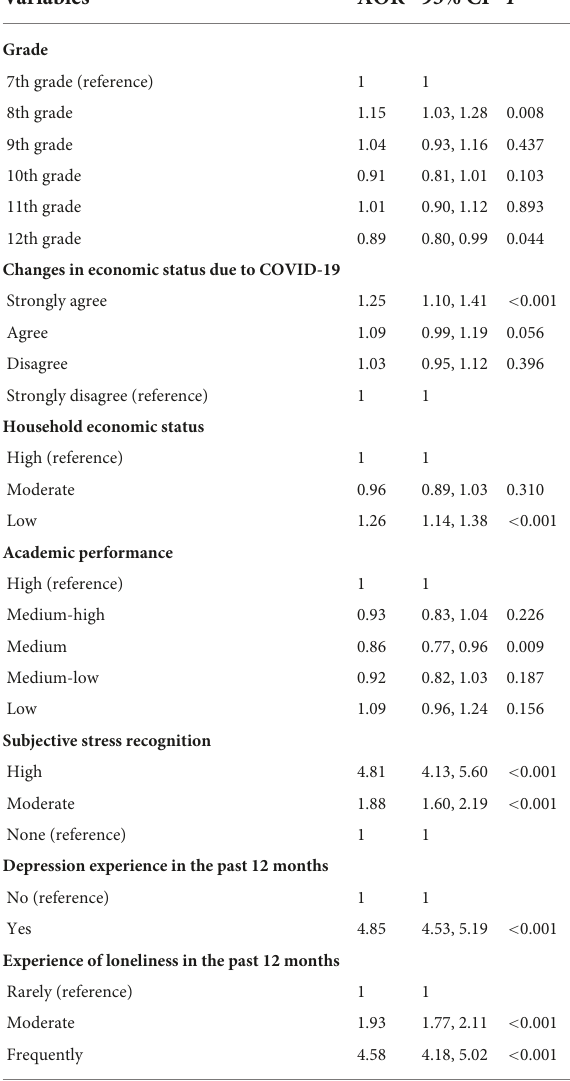
TABLE 2 Predictors for suicidal ideation in South Korean adolescents: AOR and 95%